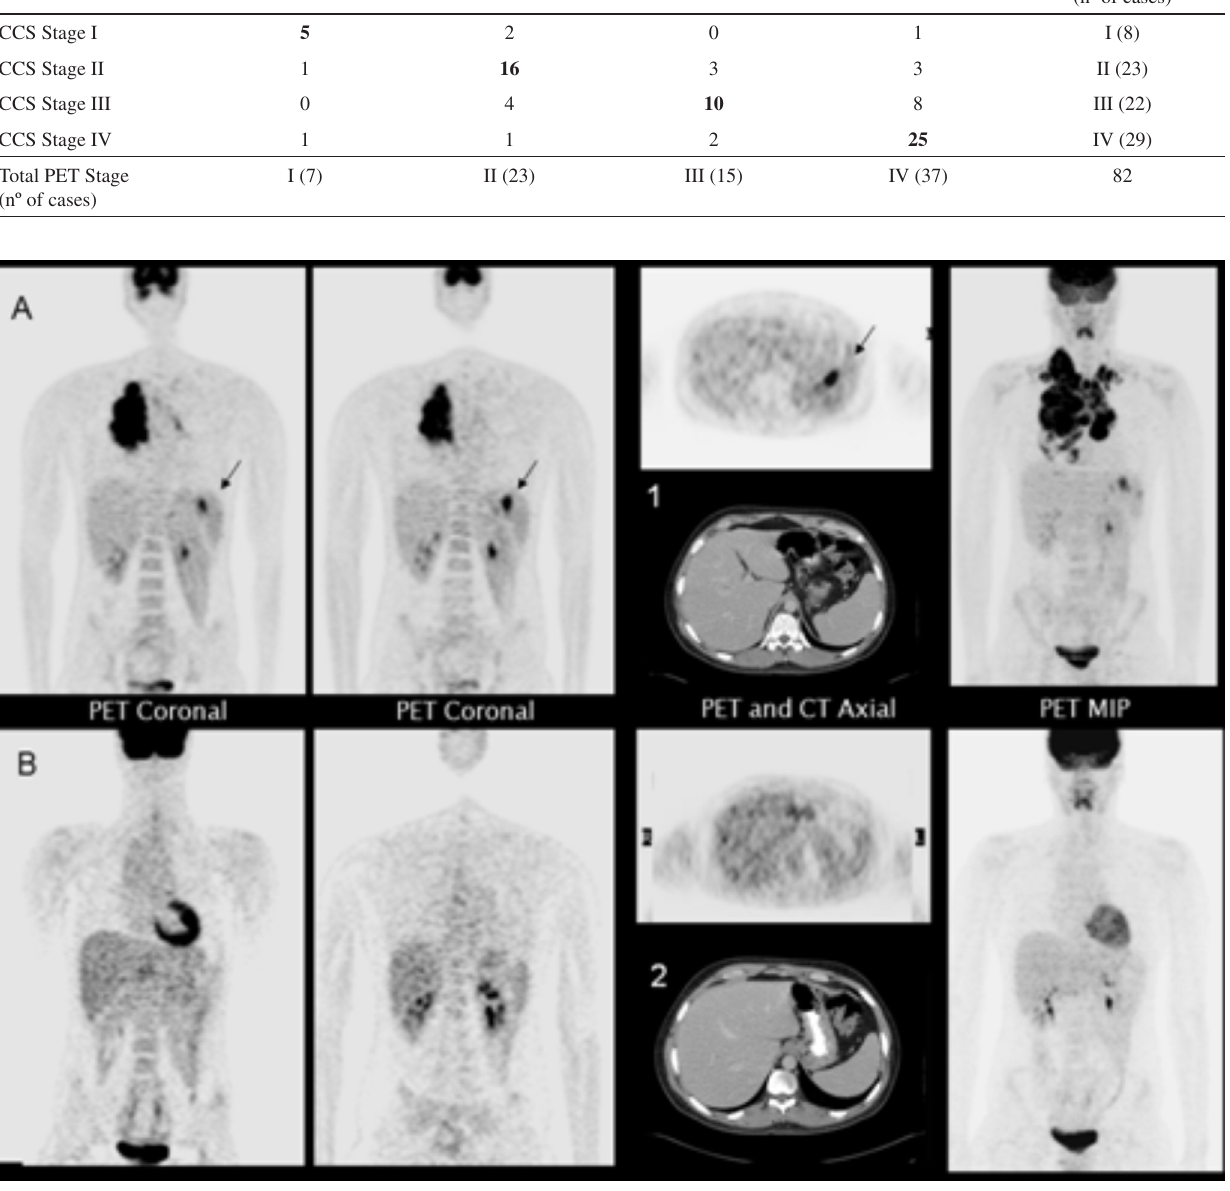
Figure 1 - A 22-year old male patient with conventional clinical stage II disease. A) FDG-PET coronal, axial and maximum intensity projection (MIP) images showed additional splenic lesions (arrows) not observed in the CT axial image (1). B) After two ABVD cycles, all lesions, including the splenic foci, disappeared; normal CT axial image